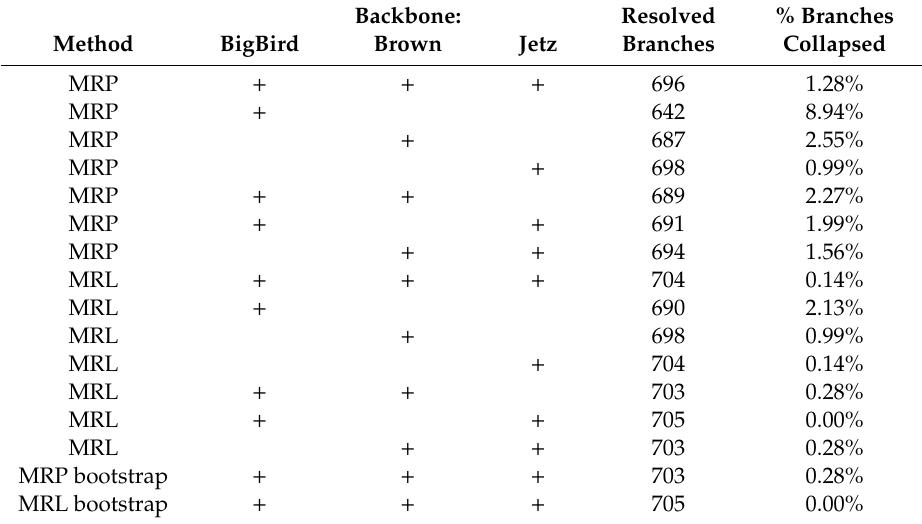
Table 2. Supertree resolution given di ff erent backbone trees 1 .